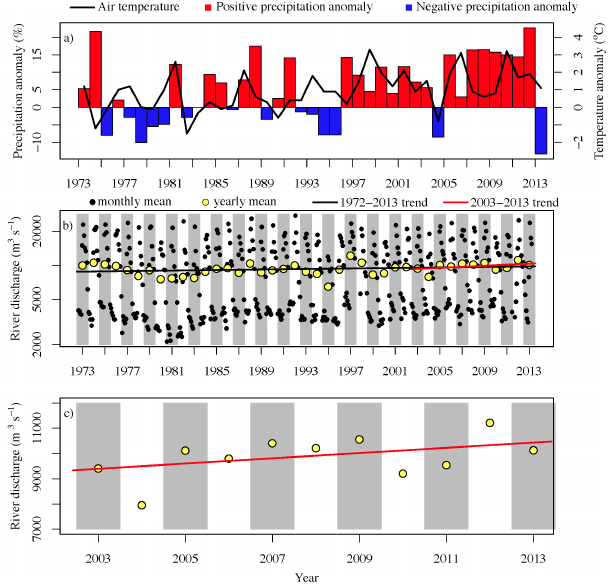
Figure 1. Variations in air temperature and precipitation anomalies observed in the Mackenzie drainage basin from 1973 to 2013 (a) . Variations in the Mackenzie freshwater discharge (monthly and yearly averages); trends observed between 1973 and 2013, and be- tween 2003 and 2013 (b) . Zoom on the variations in the Mackenzie freshwater discharge between 2003 and 2013 (c) .